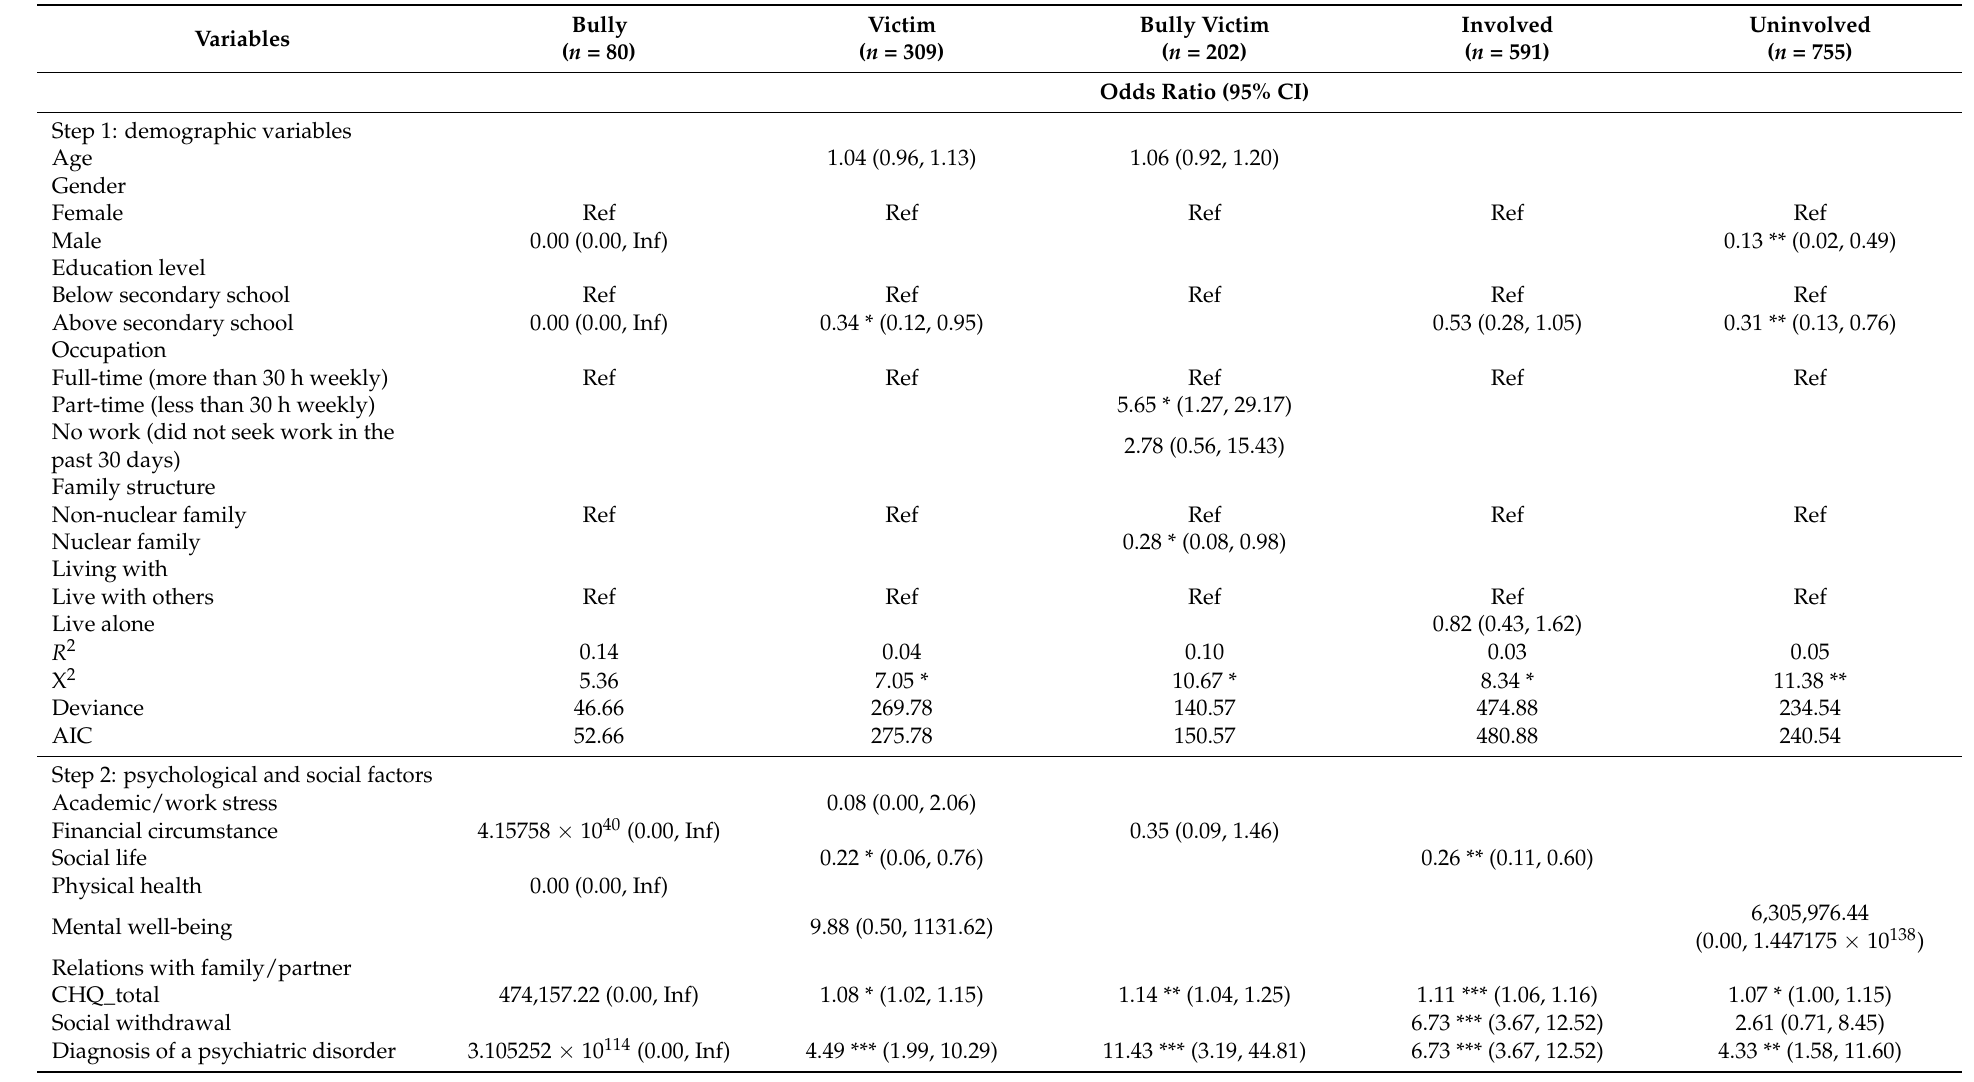
Table 4. Summary of hierarchical multiple logistic regression predicting suicide